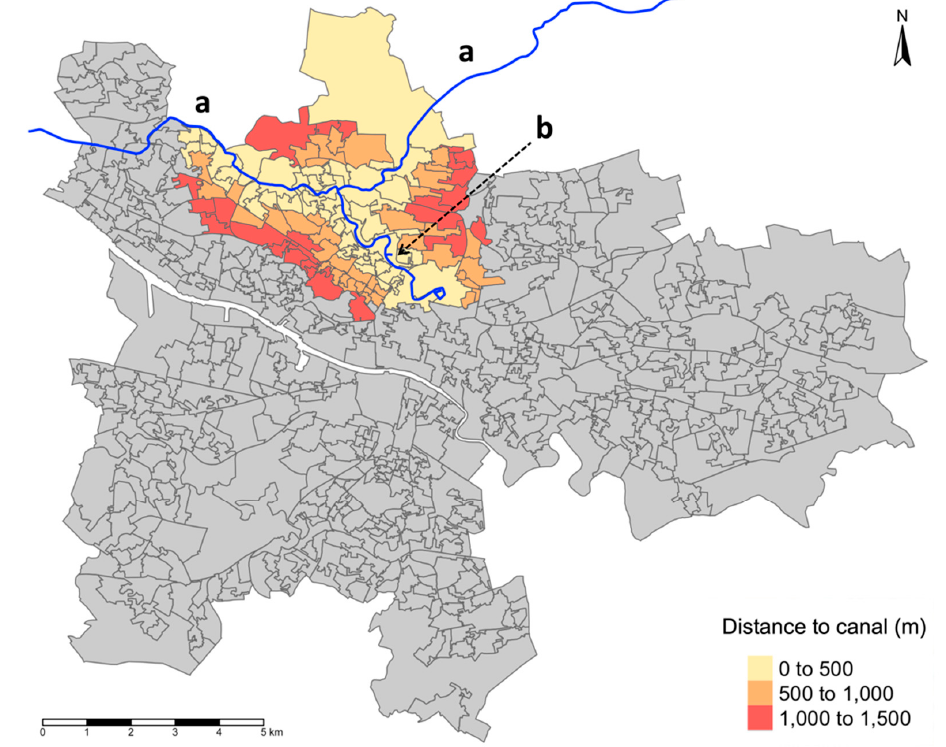
Figure 1. Glasgow city’s 694 data zones according to the 2001 Scotland Census and the Glasgow canal (blue line) comprising ( a ) the Forth and Clyde canal and ( b ) the Glasgow branch. The study area was split into three distance buffers (0–500, 500–1000, and 1000–1500 m), based on the Euclidian (i.e., straight-line) distance between the population-weighted centroids and nearest portion of the canal.